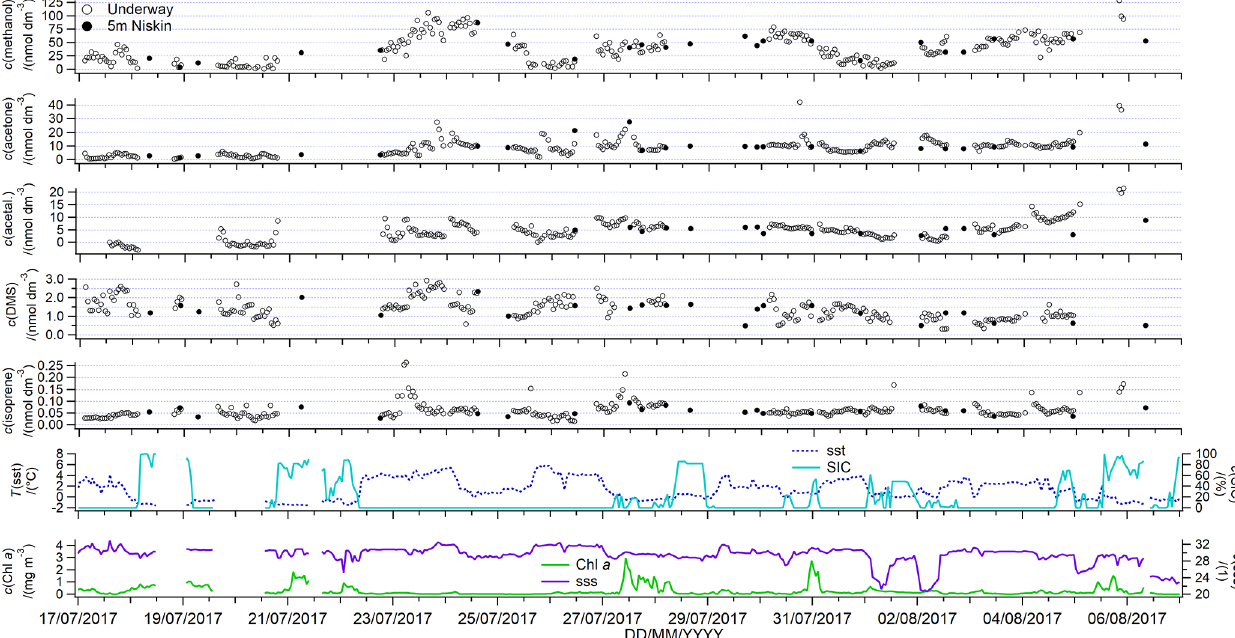
Figure 8. Underway surface water concentrations of dissolved gases. Plotted along are underway SIC, SST, Chl a , and salinity (Amundsen Science Data Collection,